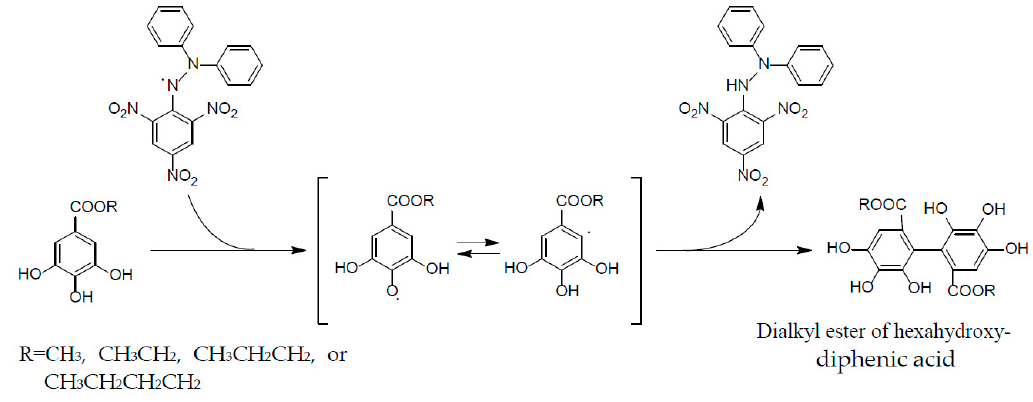
Figure 7. Formation of dialkylester of hexahydroxydiphenic acid in radical reaction of alkyl gallate with DPPH.